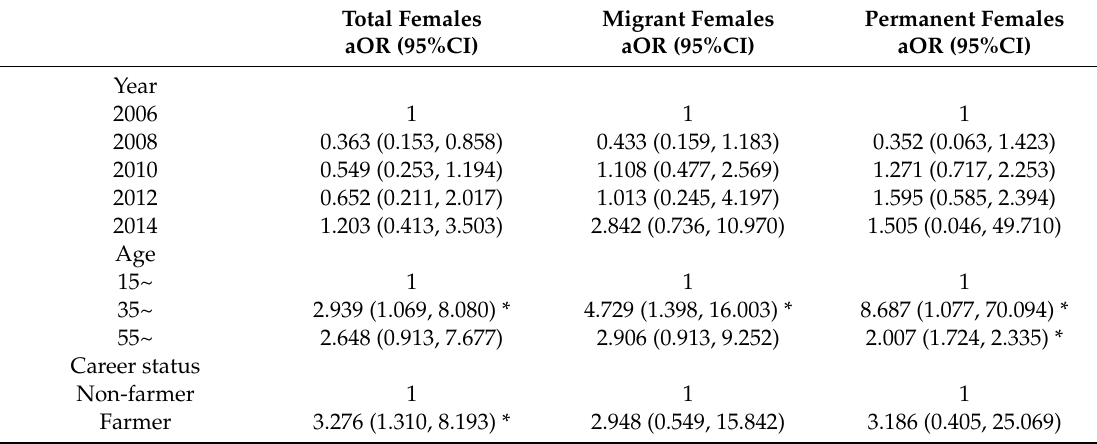
Table 6. The analysis results of the early leaving hospital against medical advice using complex sampling Logistic regression of females aged 15 and over among total females, migrant females, and permanent